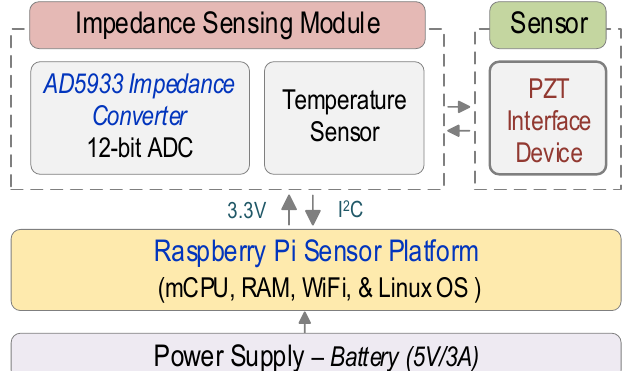
Figure 1. Raspberry Pi platform impedance monitoring system ‘ SSeL-Pi ’ .